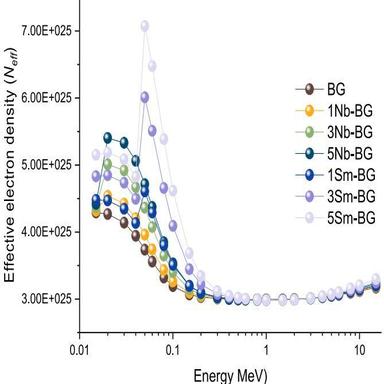
Variation of effective electron density (Neff) as a function of increasing energy.